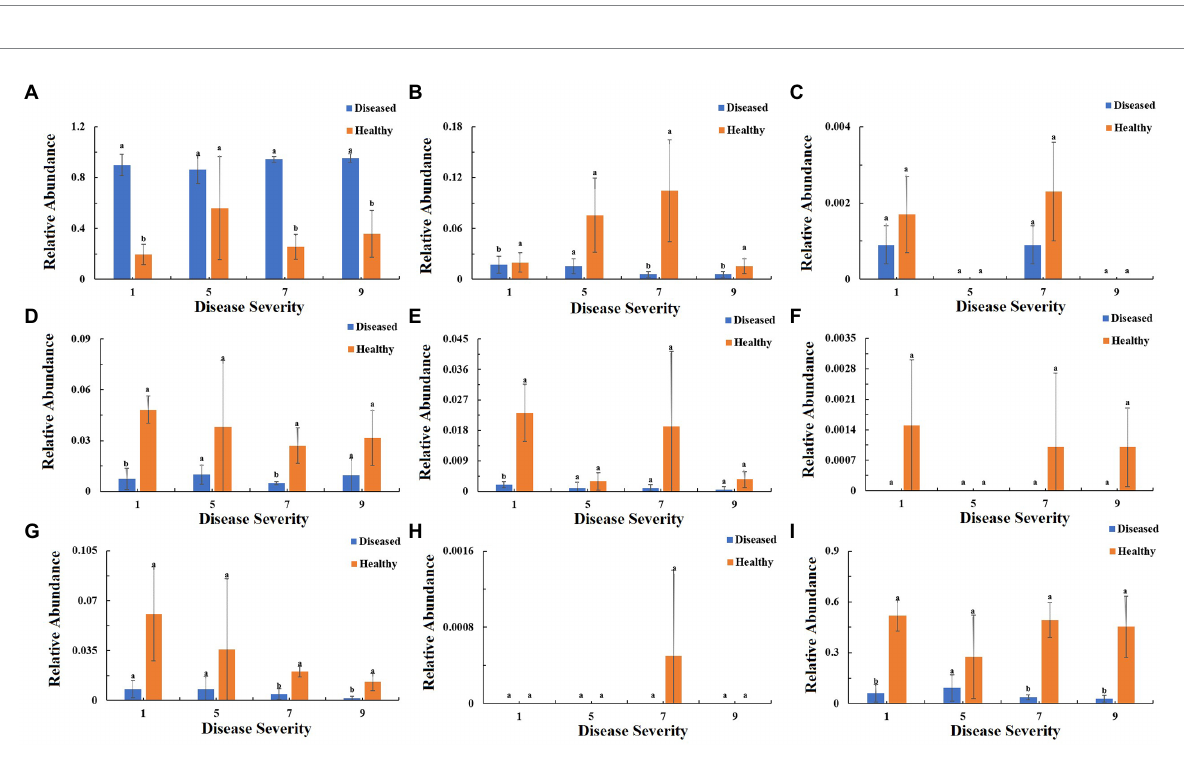
FIGURE 9 Relative abundance of fungal functional groups (modes) based on OTU annotation table with disturbance frequency level. (A) Pathotroph, (B) Saprotroph, (C) Symbiotroph, (D) Pathotroph-Saprotroph, (E) Pathotroph-Symbiotroph, (F) Pathogen-Saprotroph-Symbiotroph, (G) Pathotroph-Saprotroph-Symbiotroph, (H) Saprotroph-Symbiotroph, (I)